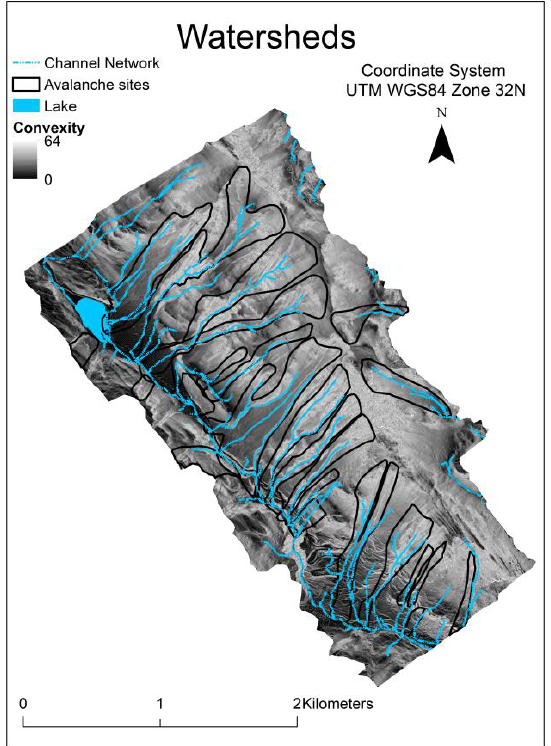
Figure 7. Channel network (i.e. watersheds) of the area (light-blue lines) generated from LiDAR derived data, which mainly corresponds to avalanche sites derived from ground observation (black